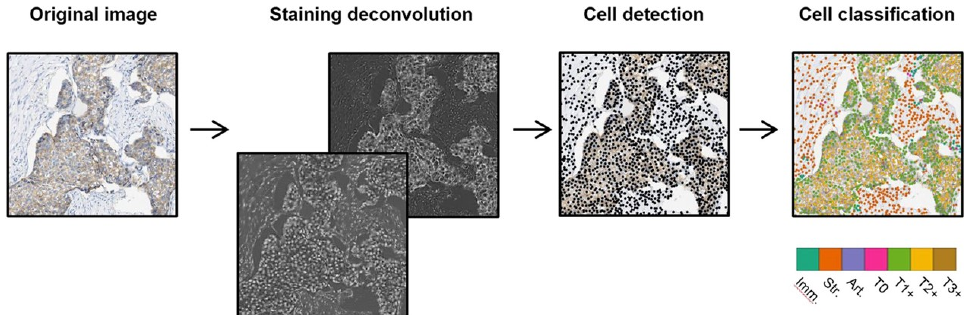
Figure 6. Detection and ranking of tumor cells. Cells are identified using a watershed algorithm and are categorized using DL into seven different types. Reproduced with permission from [142].